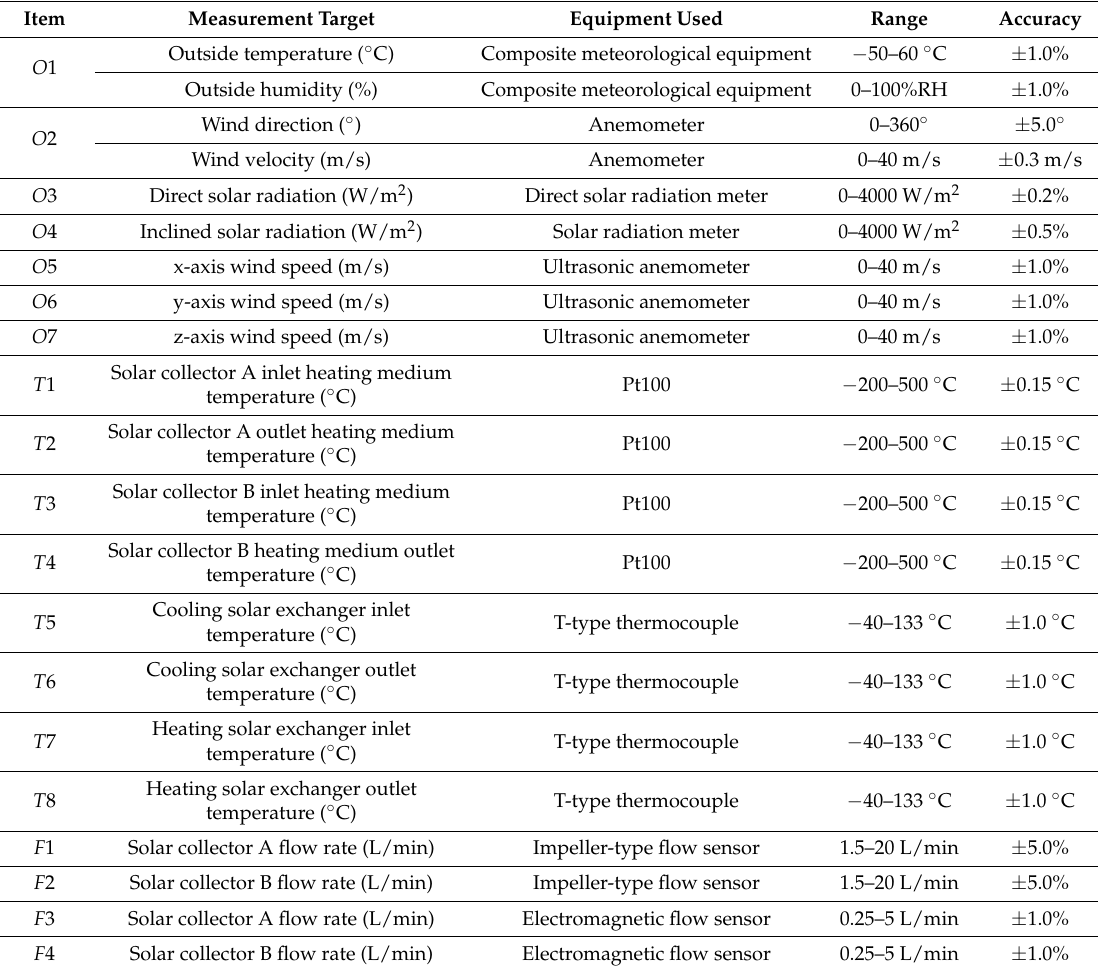
Table 1. Measurement targets and measuring